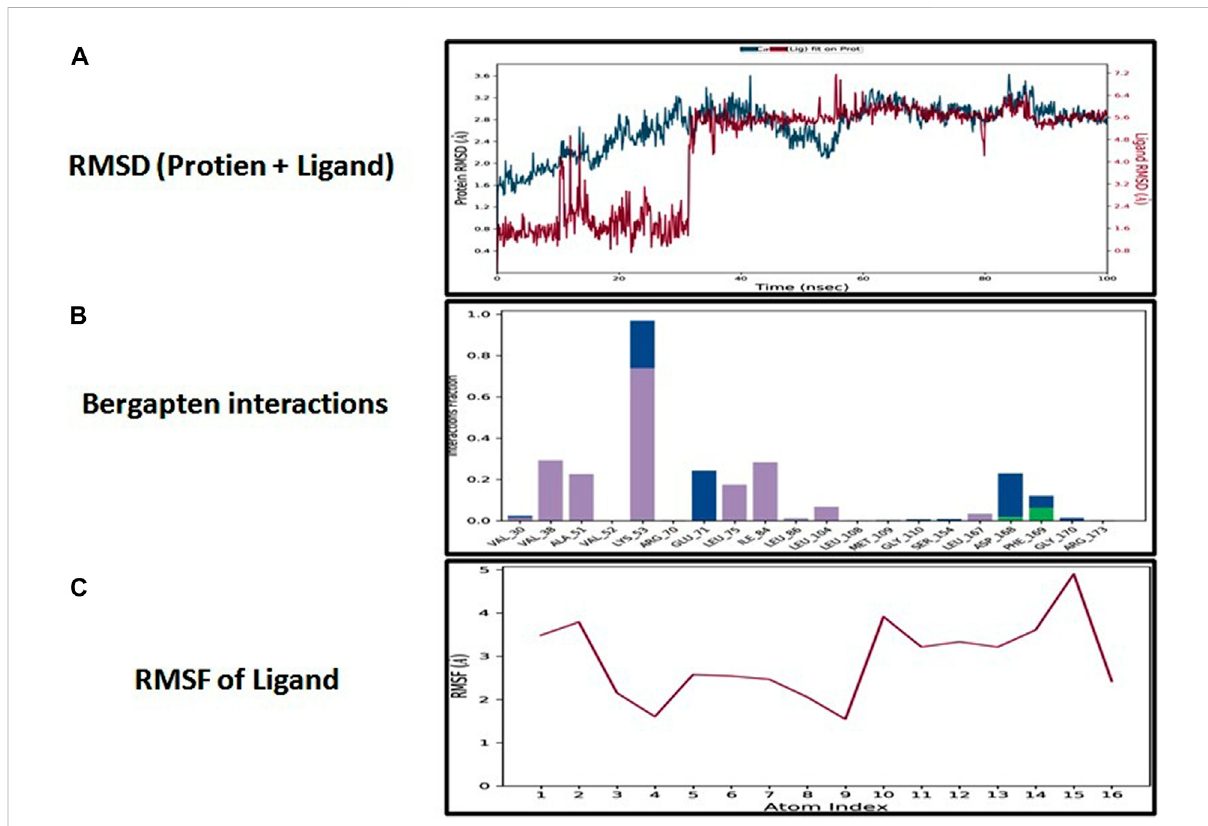
FIGURE 5 Represents root mean square deviation (RMSD) of mitogen-activated protein kinase (MAPK, PDB I.D: 5UOJ) and bergapten (A) , interactions (hydrogen bonds, hydrophobic interaction ionic and water bridges) of bergapten (B) , and root mean square fl uctuation (RMSF) of bergapten (C), obtained through Desmond software